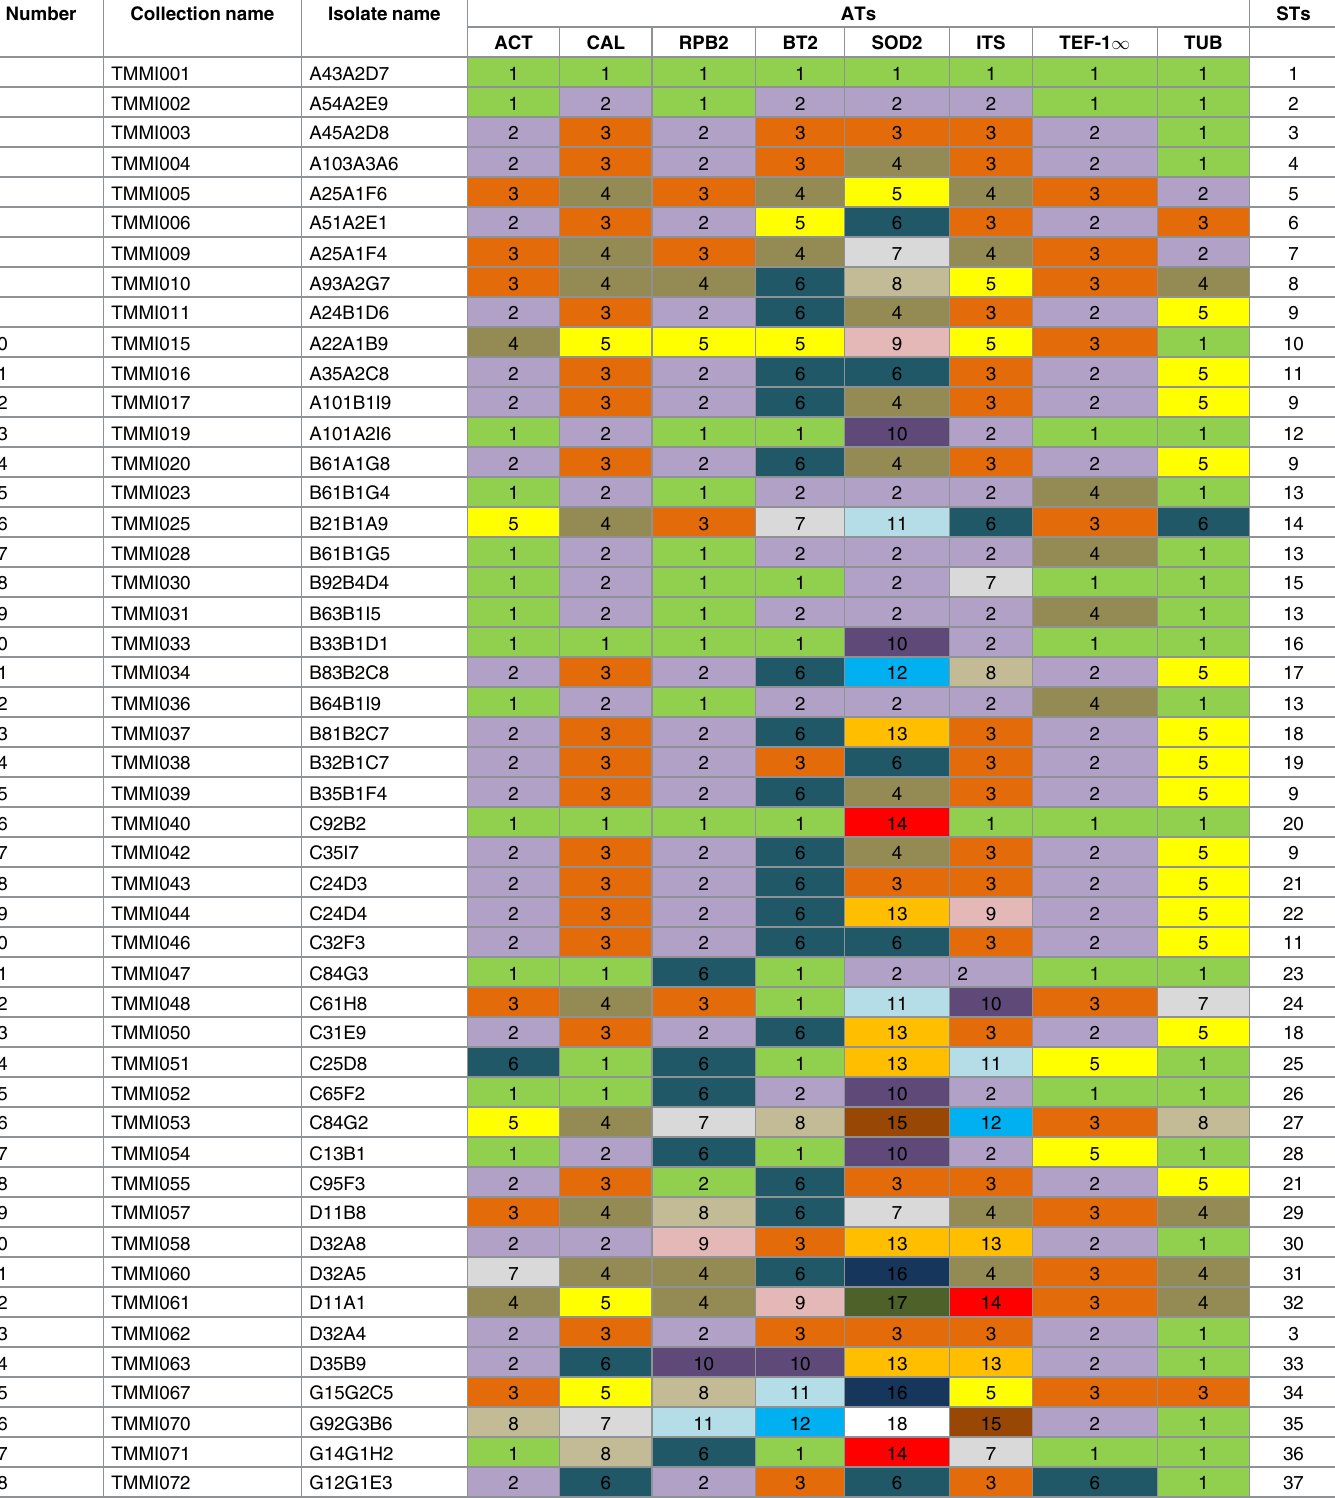
Table 4. Allele types (ATs) and sequence types (STs) of ACT, CAL, RPB2, BT2, SOD2, ITS, TEF-1 α , and TUB genes and